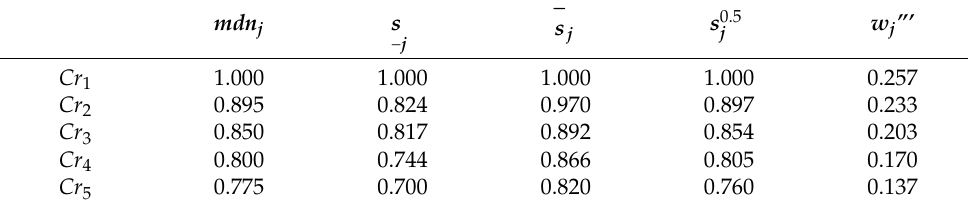
Table 10. The criteria weight obtained based on grey ratings.